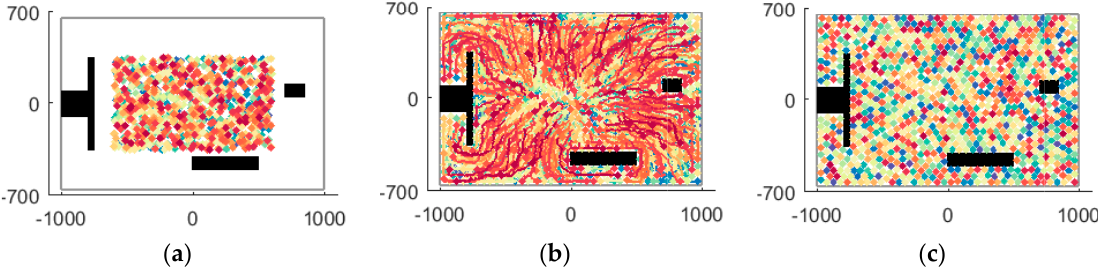
Figure 21. Cooperation coverage by 1000 UAVs. ( a ) Coverage ( t = 0); ( b ) Trajectory ( t = 0 ∼ 5226); ( c ) Coverage ( t =